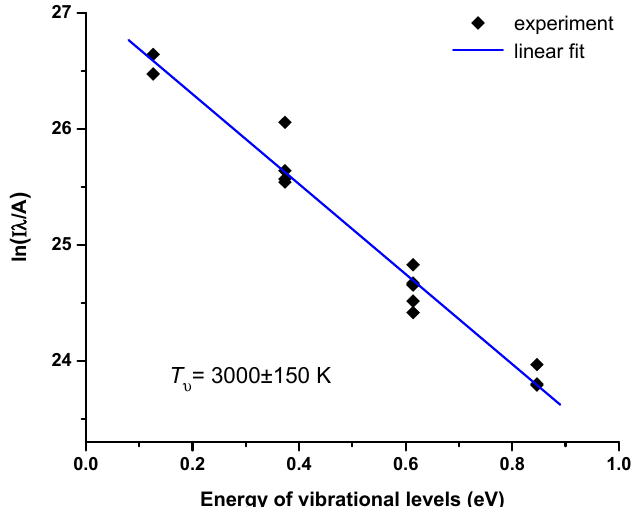
Figure 4. Boltzmann plot estimating the vibrational temperature of the nitrogen molecules.